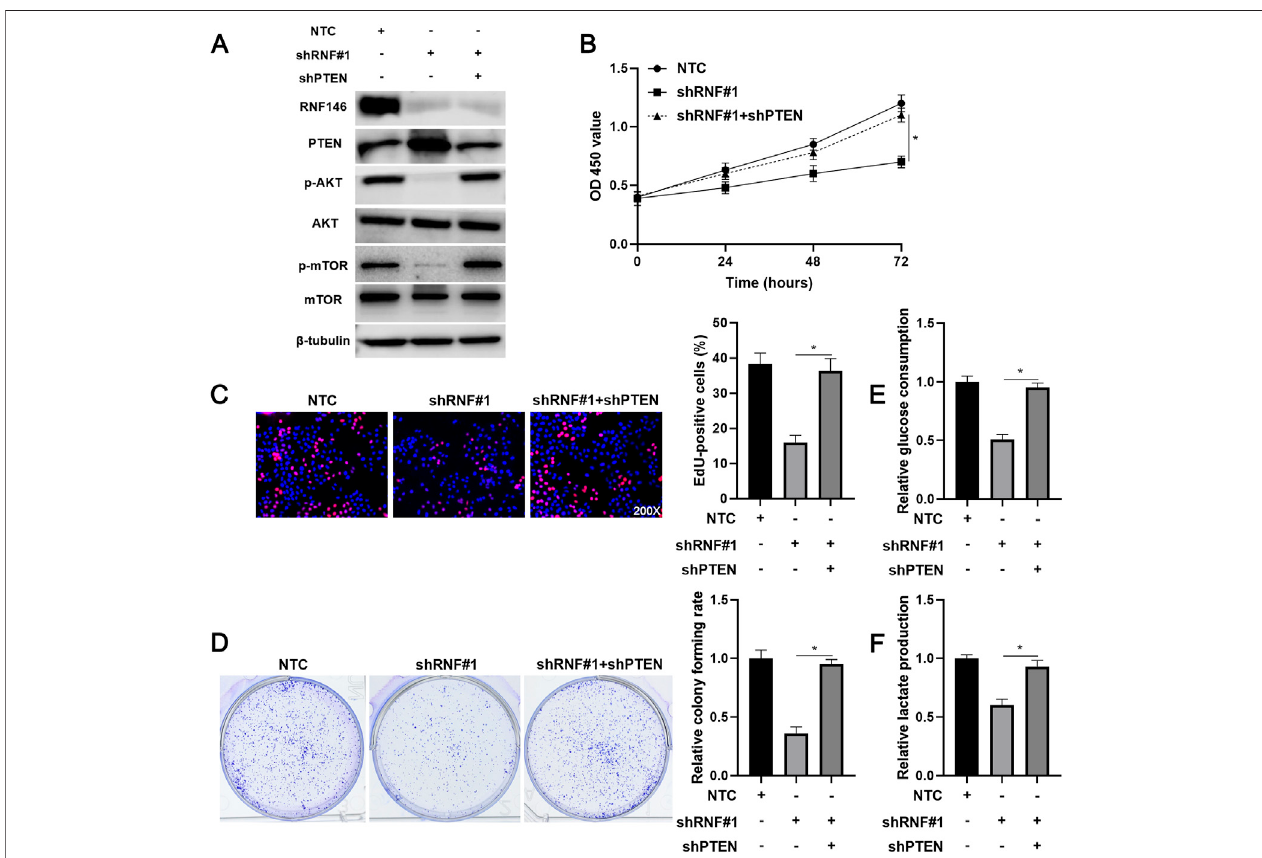
FIGURE 7 | Reducing PTEN expression abolishes the effects of RNF146 knockdown in HCCLM3 cells. (A) HCCLM3 cells that were transfected with NTC, shRNF#1 or shRNF#1 + shPTEN were detected by WB for the RNF146, PTEN, p-AKT (Ser473), AKT, p-mTOR (Ser2448) and mTOR levels. (B) CCK-8, (C) EdU, (D) colony formation, (E) glucose consumption and (F) lactate production assays were performed to detect the proliferation, colony formation and glycolysis of HCCLM3 cells with or without RNF146 overexpression. * p < 0.05.